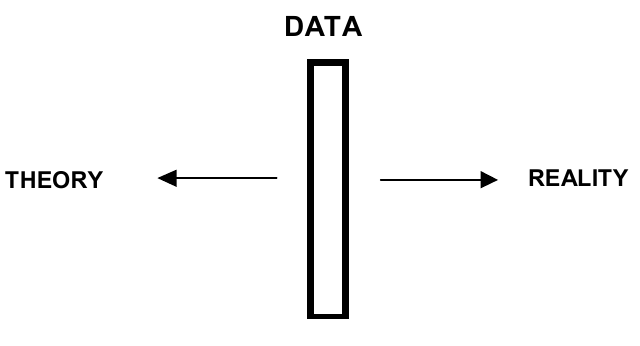
Figure 1: The Dual Orientation of the Data Analysis